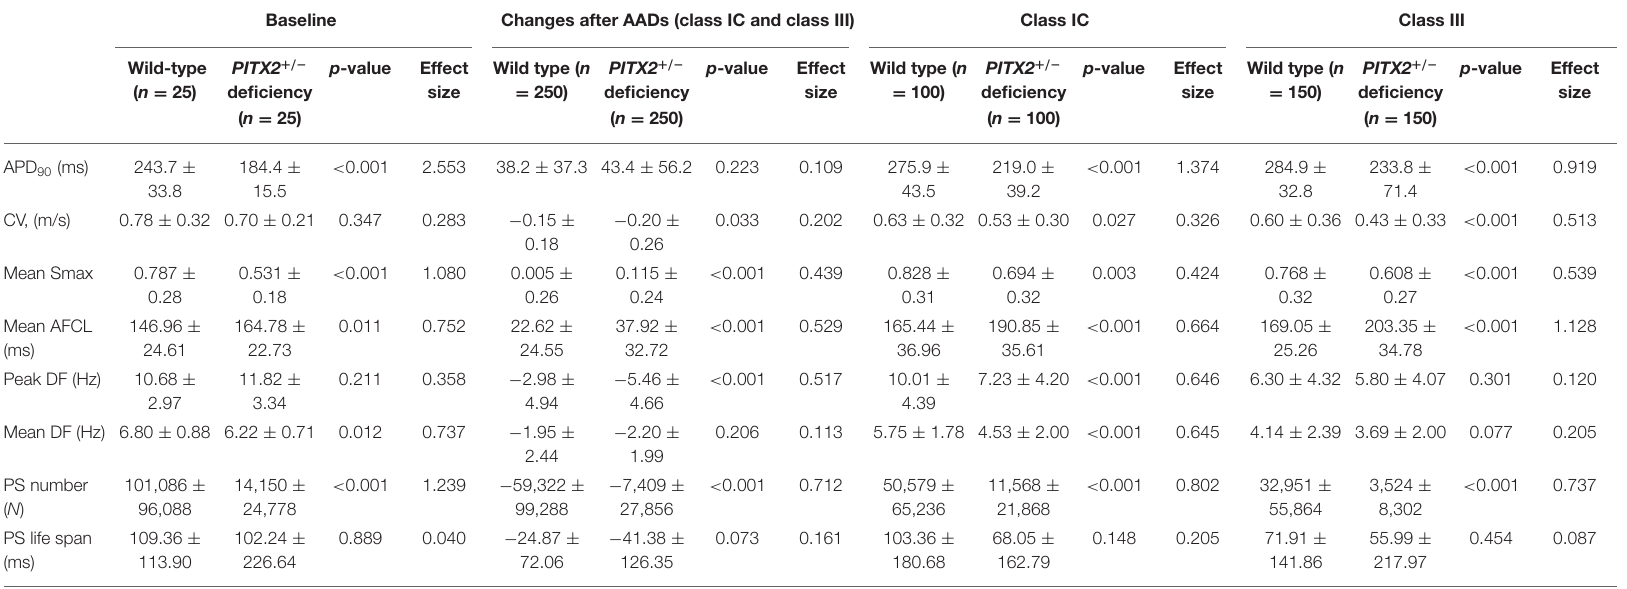
TABLE 3 | Effects of AADs in the wild-type and PITX2 + / − deficiency